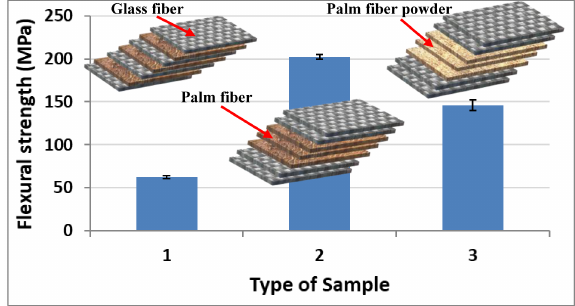
Fig. 8. The impact of fiber layering order and form on the flexural strength.